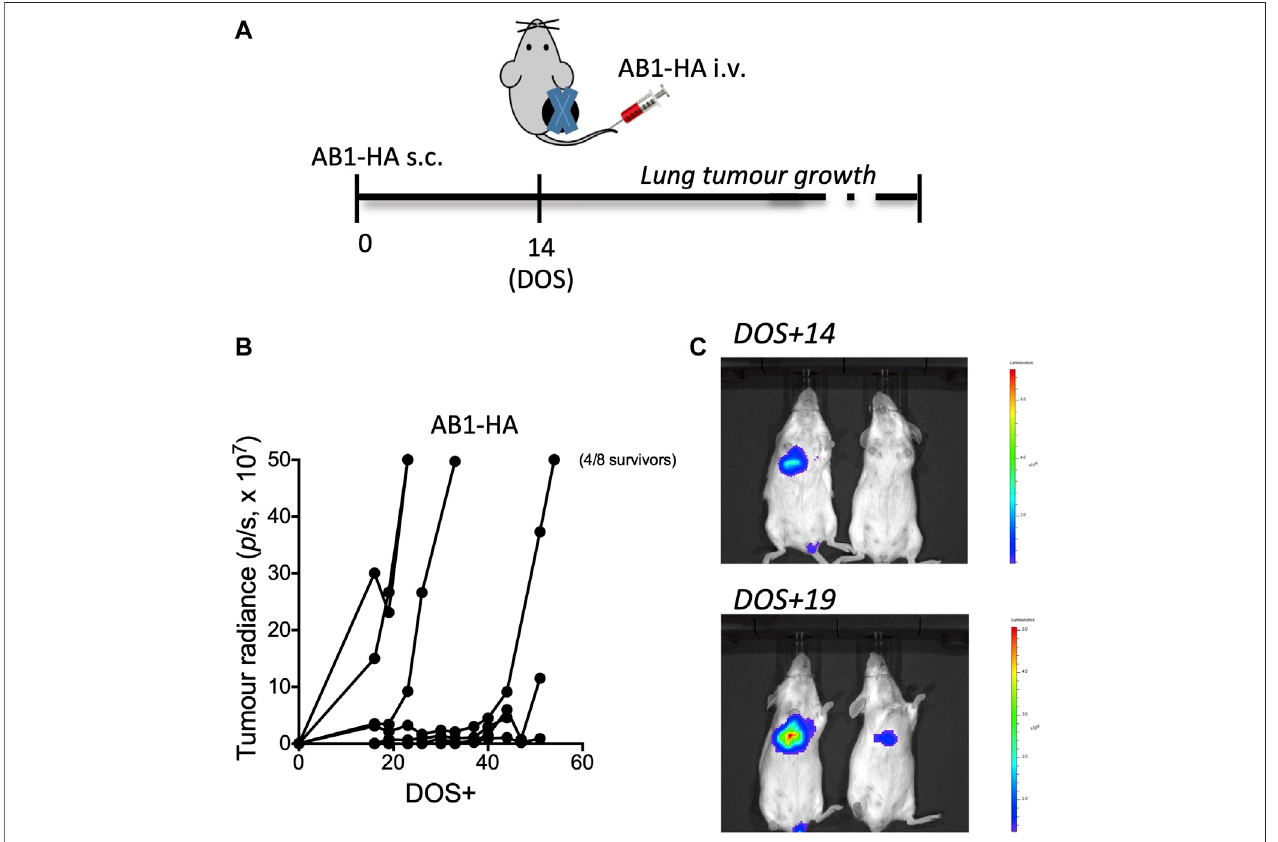
FIGURE 4 | Early detection of metastatic lung disease by immune recognition versus PET-CT. To compare immune responses to neo-antigens with PET-CT in terms of sensitivity to recurrence of metastatic tumour. Mice received AB1-HA cells day 0 and AB1-HA_LUC cells intravenously on day 14. Tumours were surgically resected to mimic cancer surgery and lung tumour growth, as a measure of the appearance of metastases, was measured in an invitro imaging system (IVIS) (A) Experimentalplan (B) lungtumourgrowthbyIVIS (C) IVISimagesofmice.DOS — dayofsurgery.FigureoriginallypublishedinFearetal.,2019.Scienti fi cReports9: